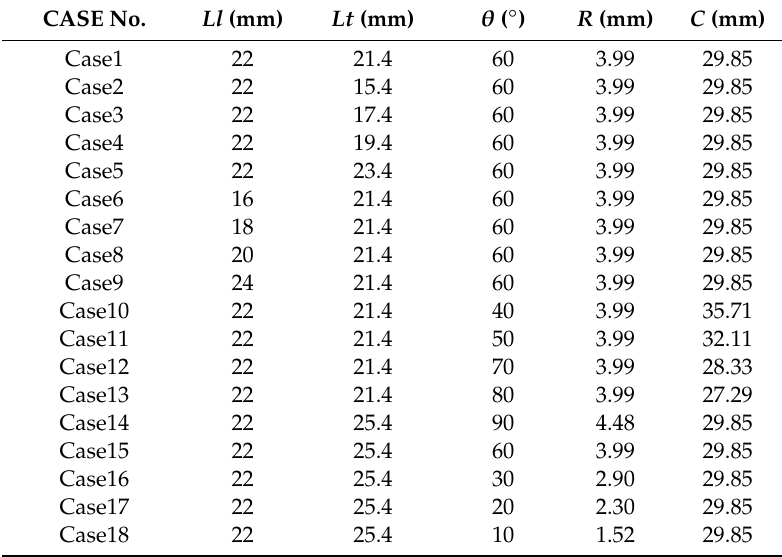
Table 2. The geometrical parameters of all the cases.